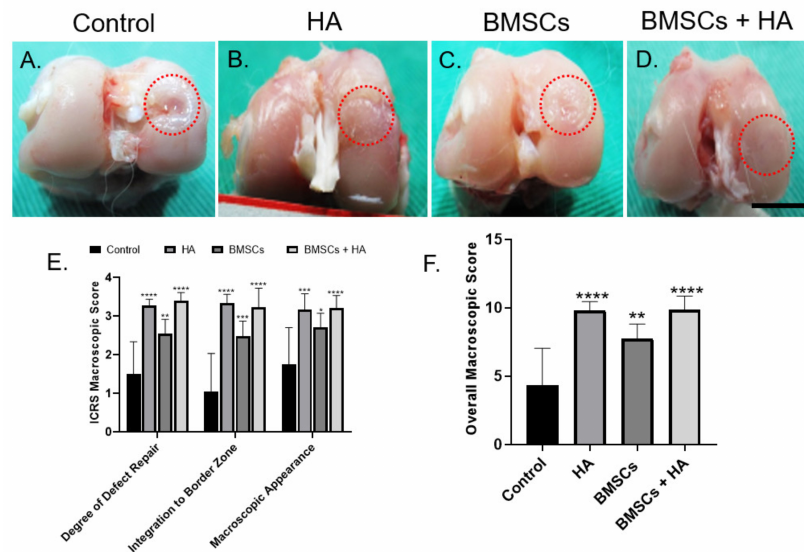
Figure 4. In vivo cartilage repair by the injection of BMSCs and hyaluronic acid supplement. Gross view and grading scale of repaired regions: ( A – D ) Macroscopic coronal views of representative defects and appearances after treatment in sham (control), HA, BMSC, and combined BMSC injection 12 weeks post-operatively (scale bar 10 mm). Red circles indicate cartilage defect regions of representative specimens from each group. ( E , F ) Quantitative gross grading scale. The bars indicate the mean ± standard deviation ( n = 6) for each group. HA, hyaluronic acid, BMSCs, bone-marrow-derived